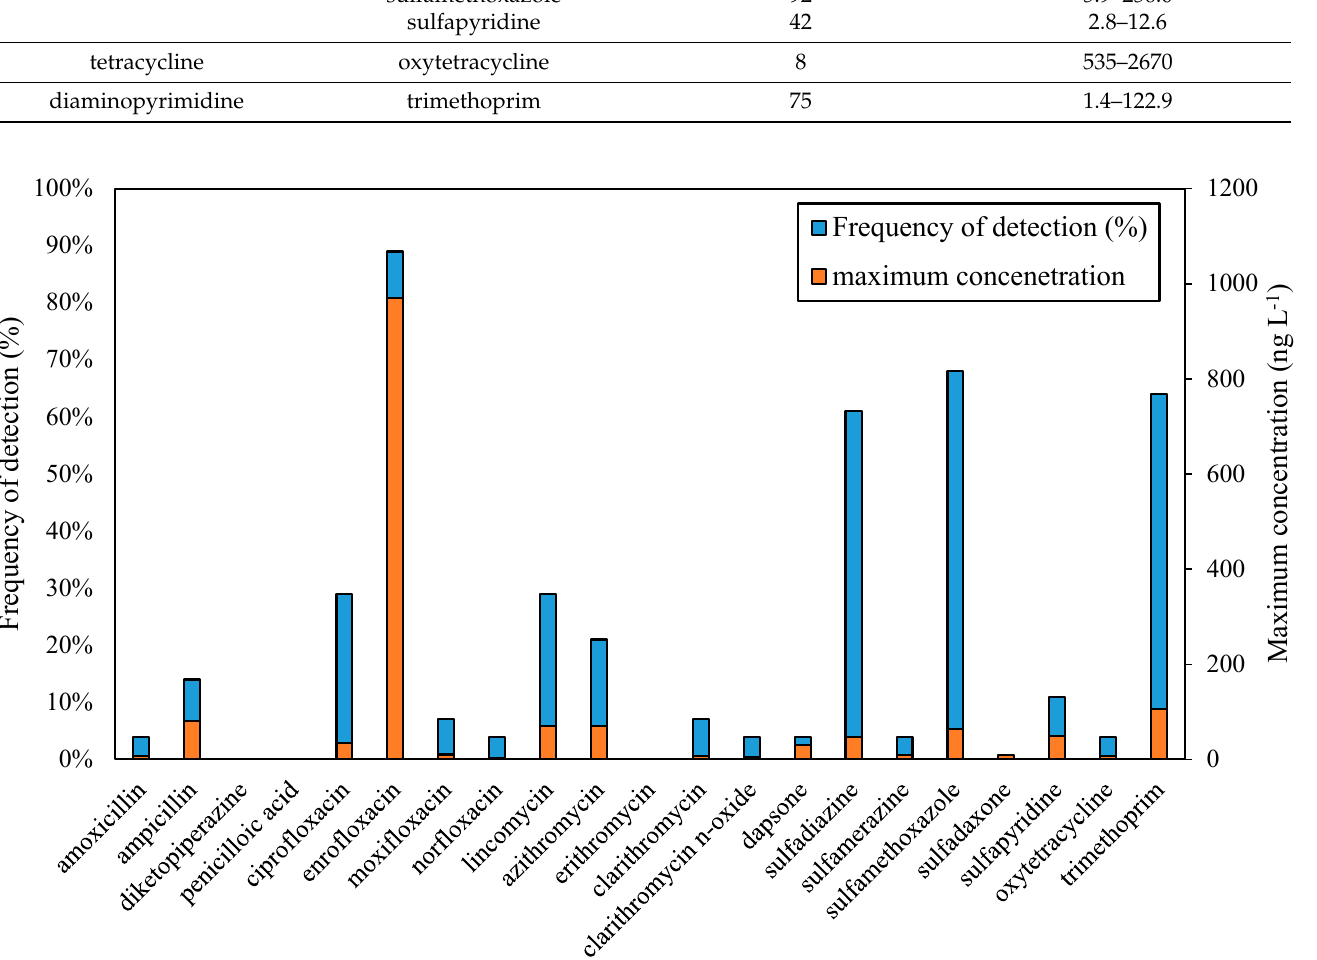
Figure 4. Detection frequency (blue bar) and maximum concentration (orange bar) of selected compounds in surface water.